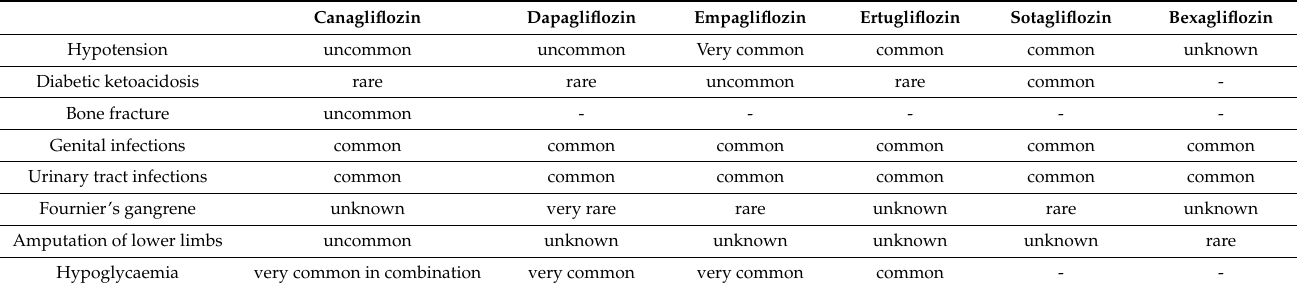
Table 2. Adverse events of SGLT2